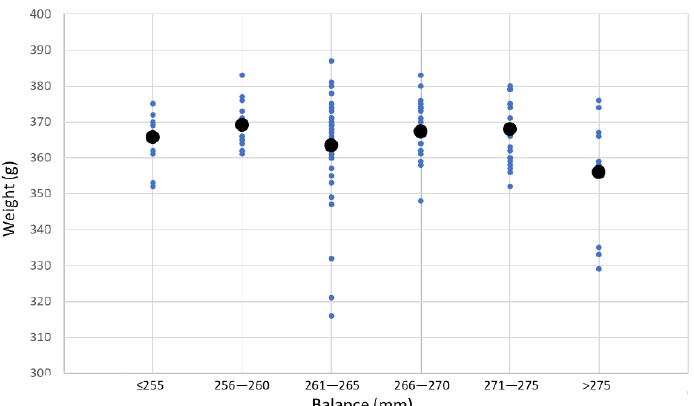
Figure 3. Weight, median values, and balance of 137 padel rackets.